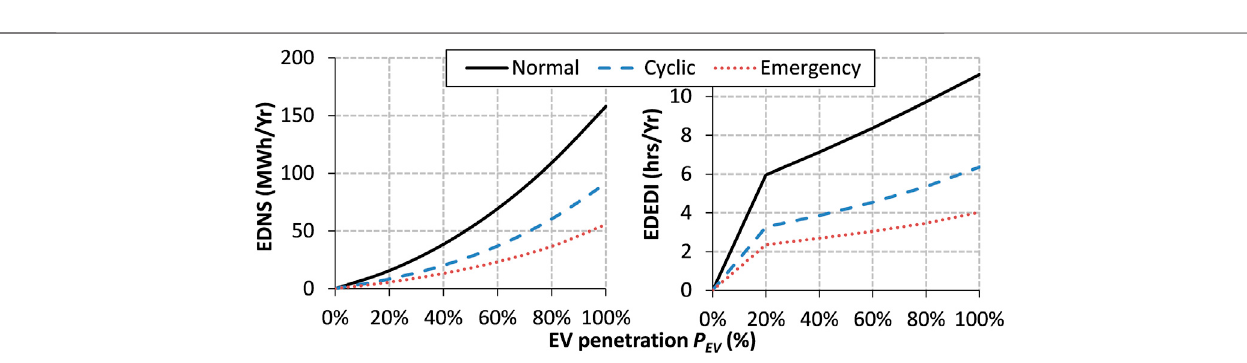
Frontiers in Energy Research |